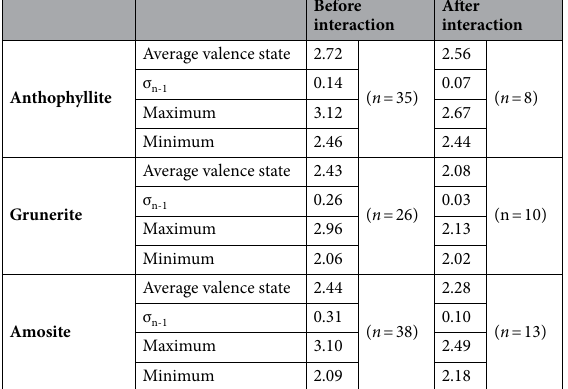
After interaction